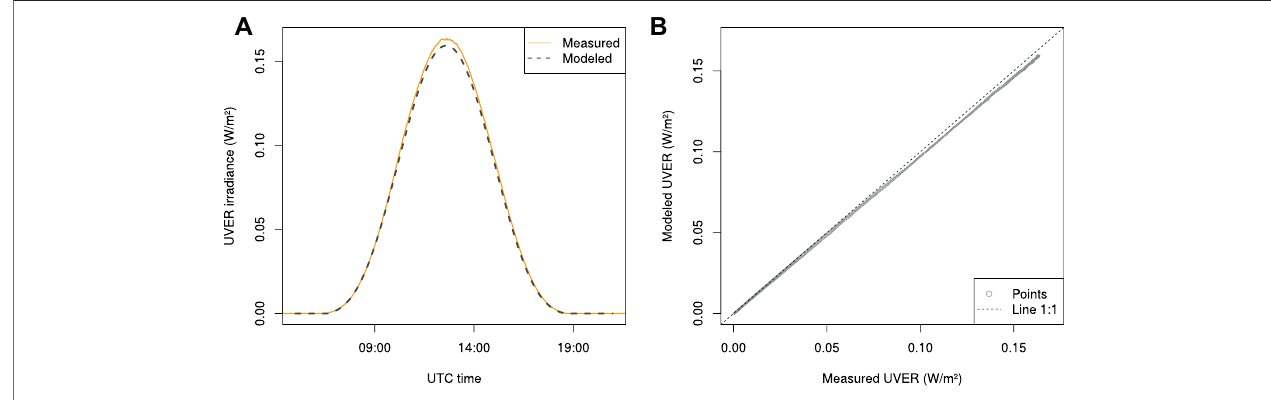
FIGURE 3 | Comparison of modeled and measured erythemally weighted irradiance during March 19, 2019: diurnal evolution (A) and regression (B)